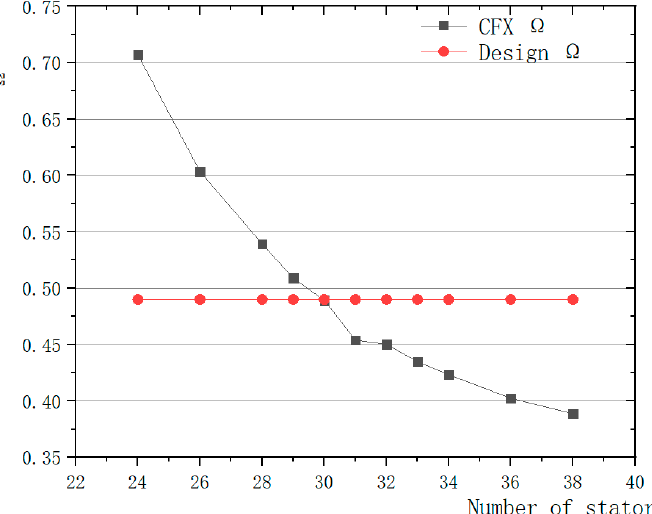
Figure 8. Comparison of design value and simulation value of reaction degree at different number of stator blades.